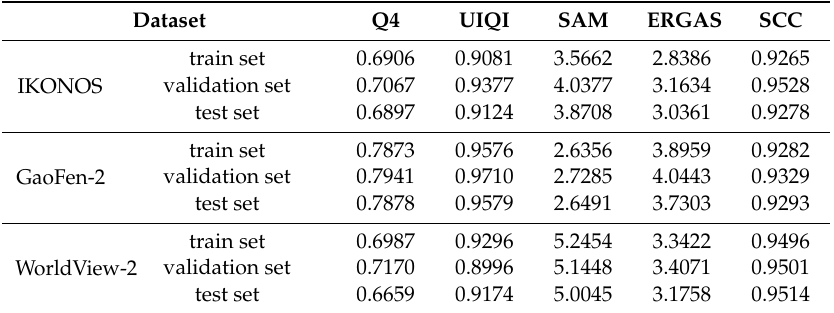
Table 5. The results of the proposed network on the train set, validation set, and test set.